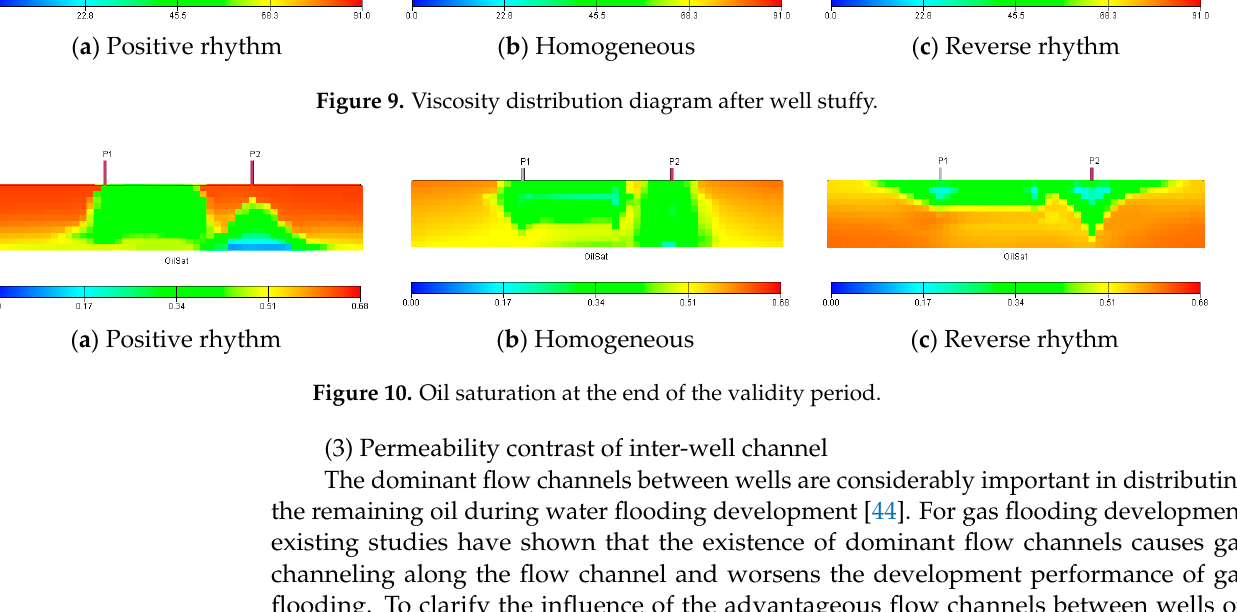
Figure 10. Oil saturation at the end of the validity period.